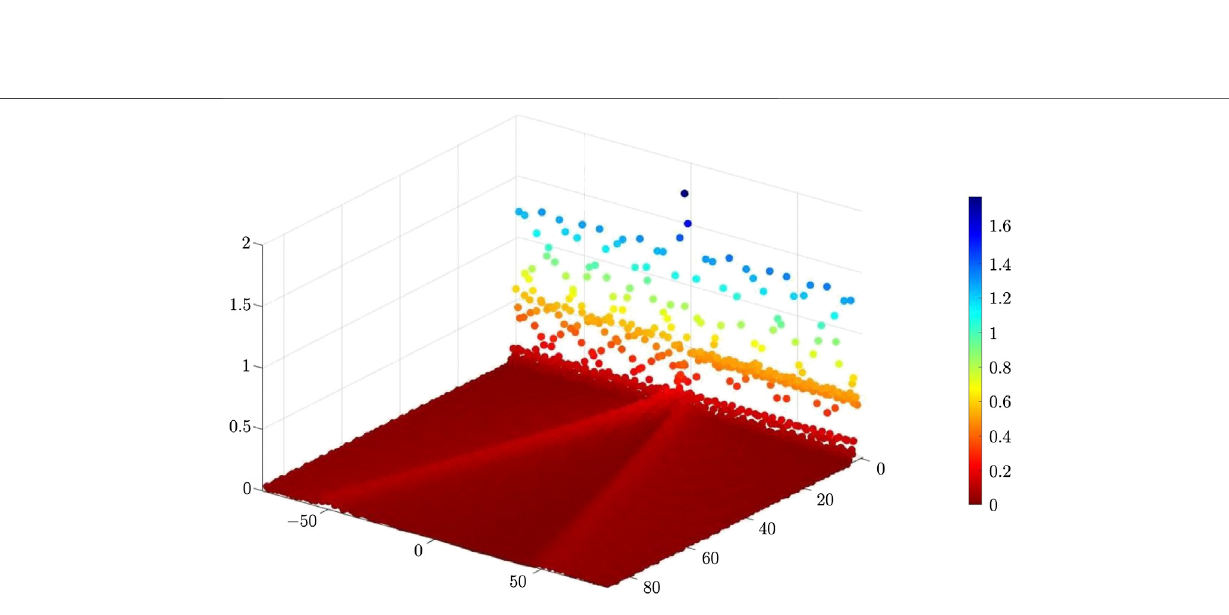
Frontiers in Materials |